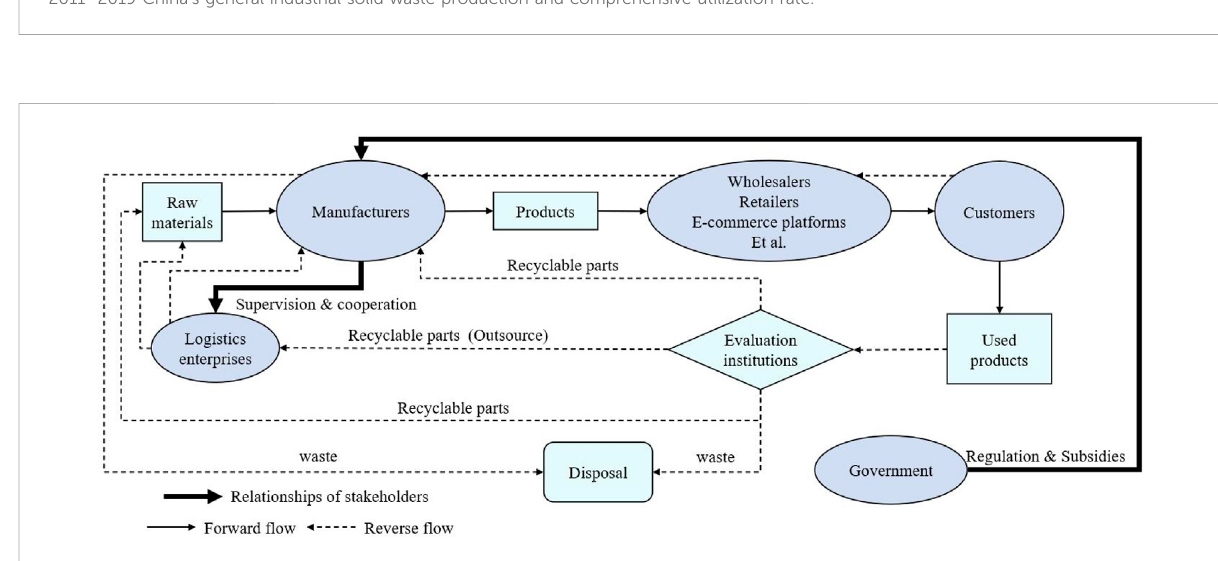
FIGURE 2 General closed-loop process with multiple parties